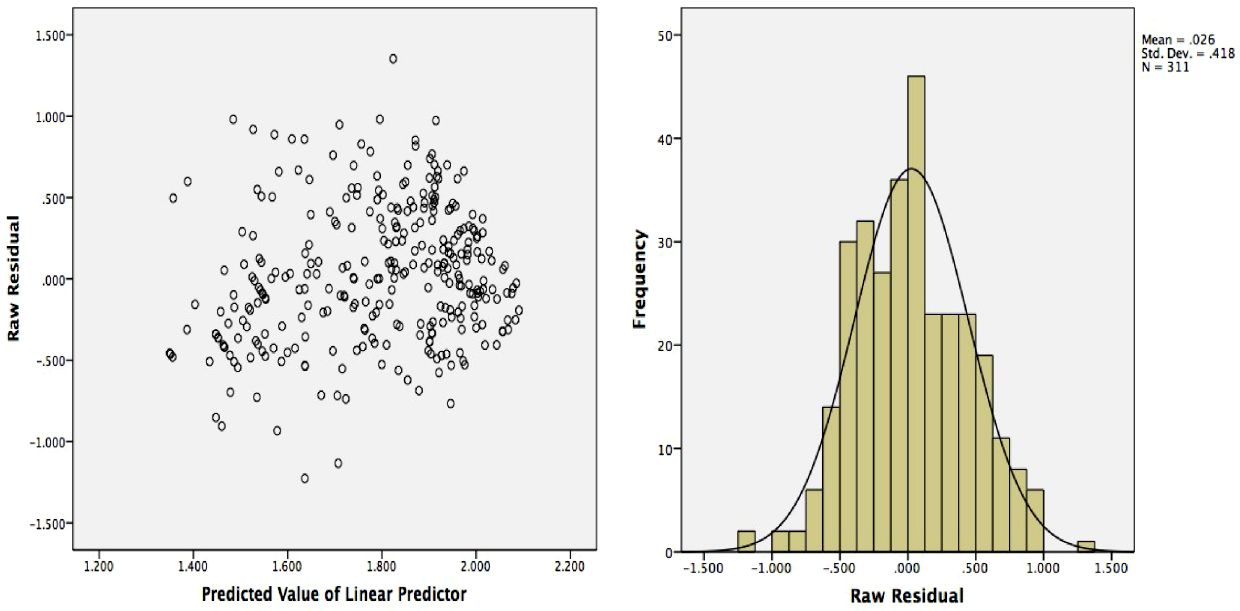
Figure 4. Distribution of residuals, with normal fit. Note: one-sample Kolmogorov–Smirnov test − the maximum absolute difference between observed frequency of residuals and normal distribution = 0.044; p = 0 . 200.